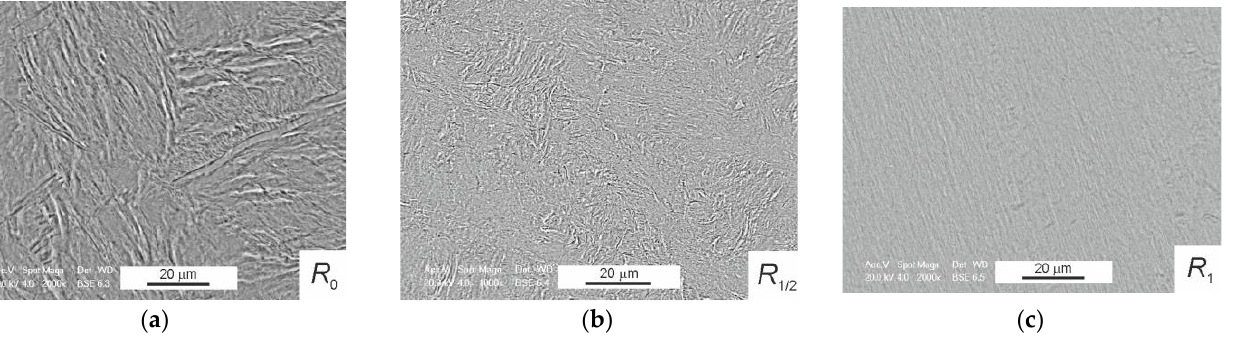
Figure 2. SEM micrographs of Ti – 1.5 wt.% Mo alloy annealed at 1000 °C for 24 h and after HPT: ( a ) R 0 is the center, ( b ) R 1/2 is the middle of the radius, ( c ) R 1 is the edge of the